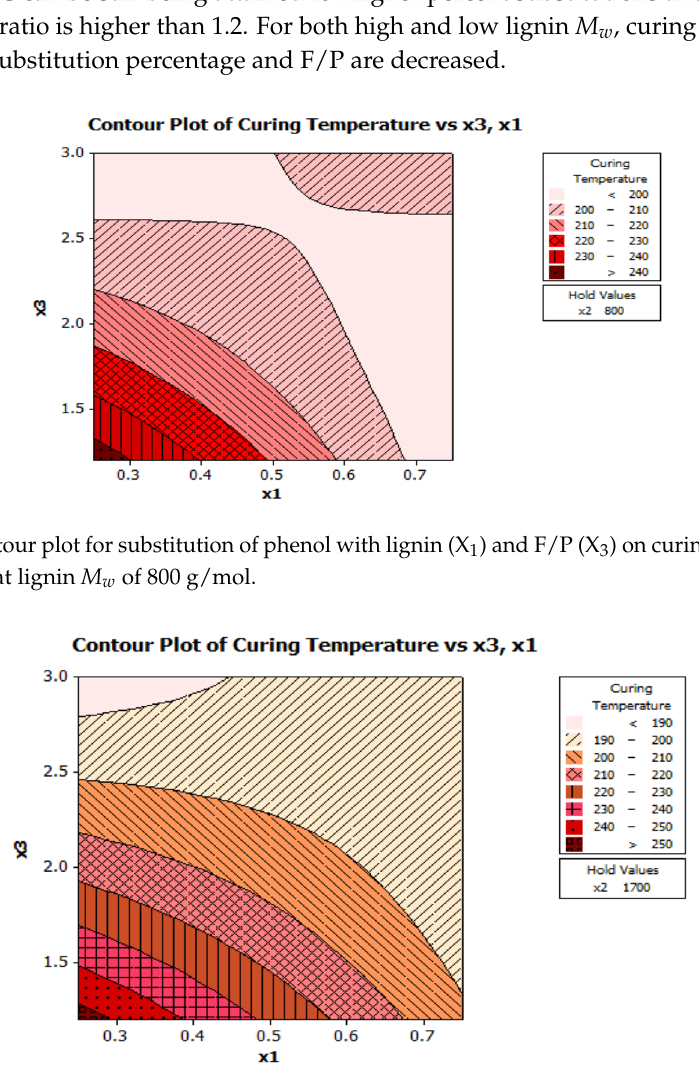
Figure 17. Contour plot for substitution of phenol with lignin (X 1 ) and F/P (X 3 ) on curing temperatures of BPF resoles at lignin M w of 1700 g/mol.